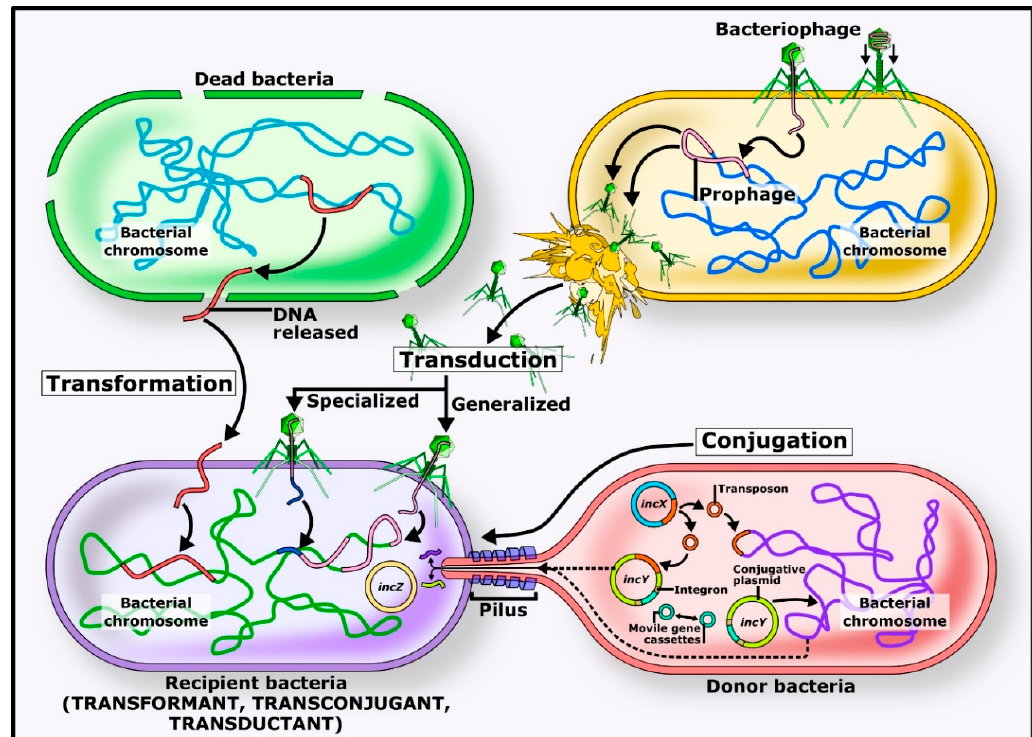
Figure 1. Involved mechanisms in horizontal gene transfer. Transduction, conjugation, and transformation are the main mechanisms by which bacterial species can mobilize and share genetic material with both related and non-related species. These mechanisms imply a pathway for the evolution of bacteria in different environments, allowing them to survive in their niches. A clear example of this is the acquisition of antibiotic resistance mechanisms, virulent traits, and other resources used by the microorganism to guarantee its survival.